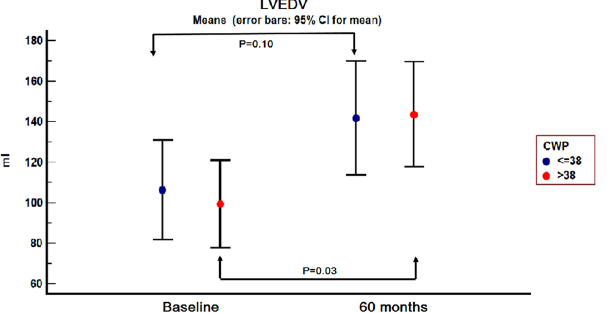
Figure 4. Left ventricular end-diastolic volume evolution in the two groups from baseline to 60 months follow-up. 95% CI = 95% confidence interval; CWP = coronary wedge pressure; LVEDV = left ventricular end- diastolic volume.